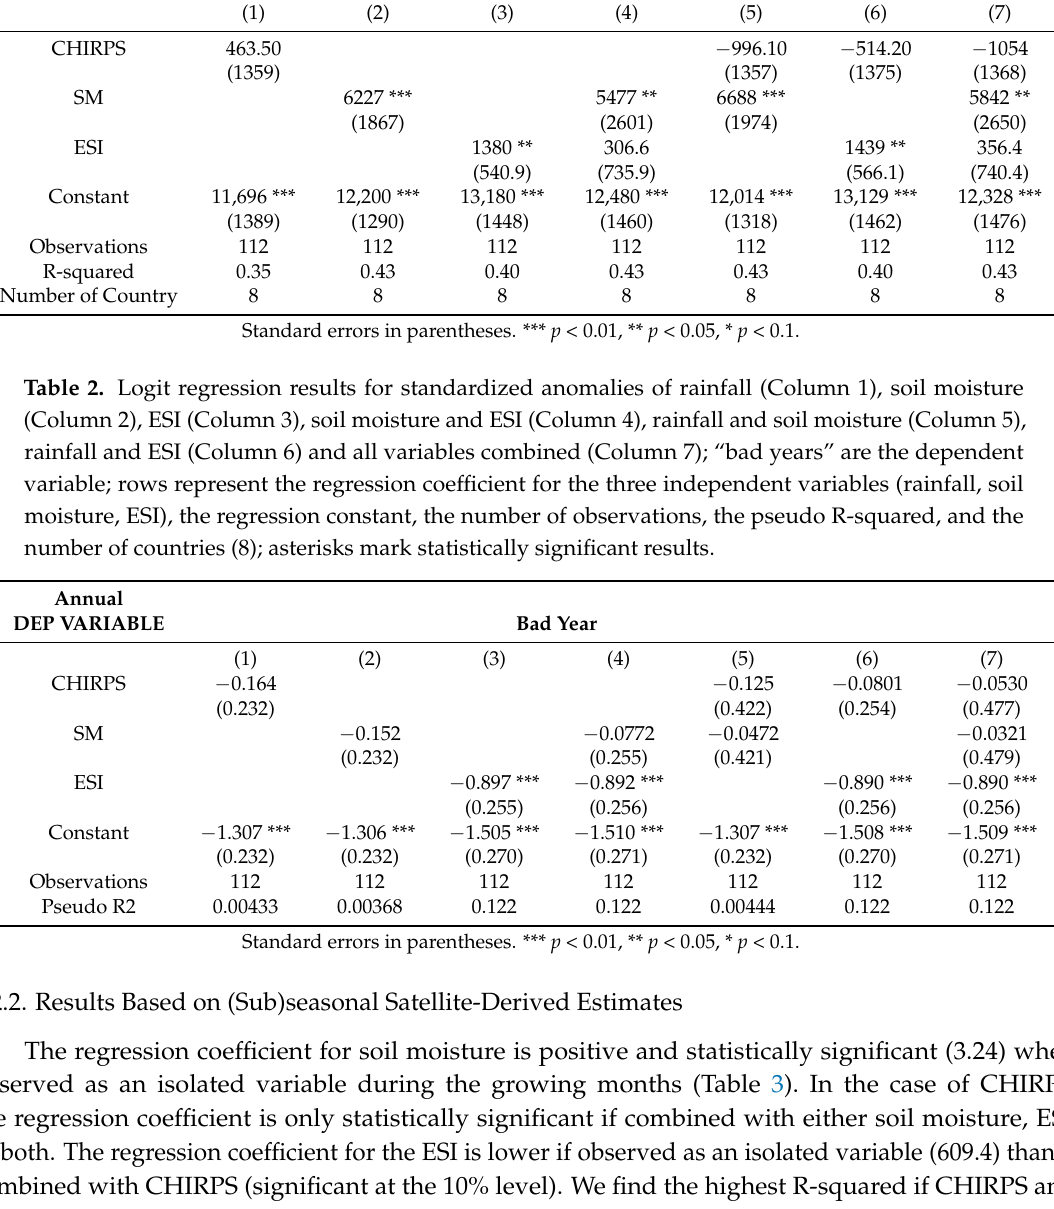
Table 1. Results of the simple linear regression with fixed effects for standardized anomalies of rainfall (Column 1), soil moisture (Column 2), ESI (Column 3), soil moisture and ESI (Column 4), rainfall and soil moisture (Column 5), rainfall and ESI (Column 6), and all variables combined (Column 7); annual maize yield is the dependent variable: rows represent the regression coefficient for the three independent variables (rainfall, soil moisture, ESI), the regression constant, the number of observations, the R-squared, and the number of countries (8); asterisks mark statistically significant results. Annual DEP VARIABLE CHIRPS